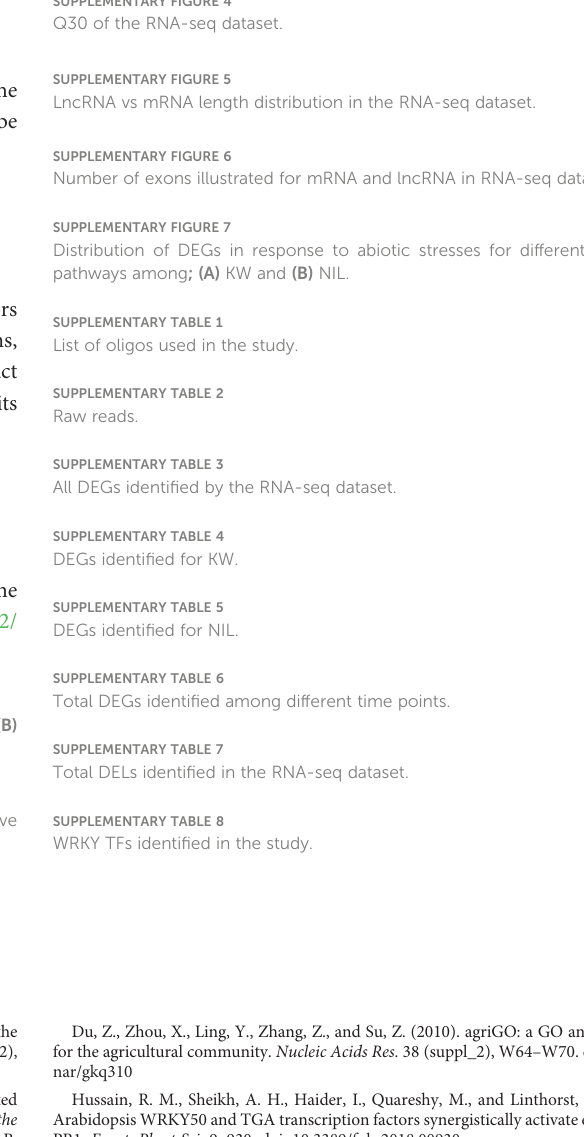
Q30 of the RNA-seq dataset.